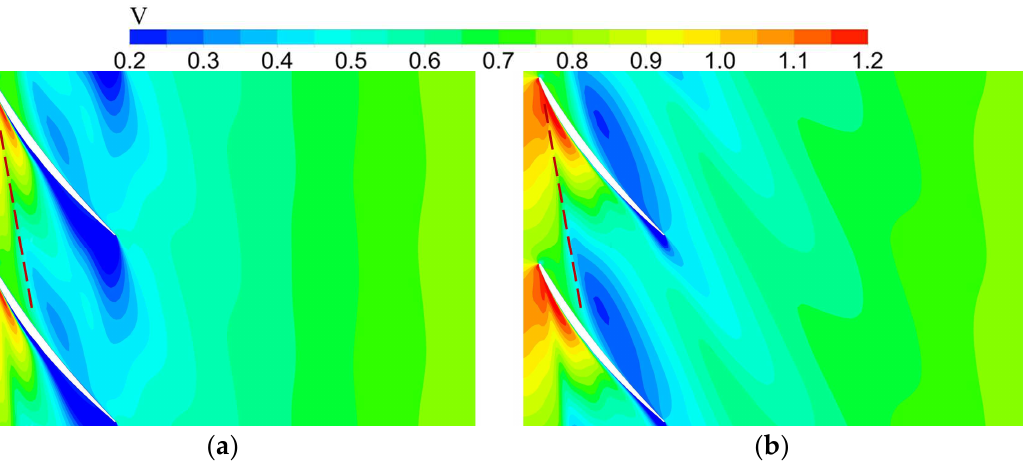
( b ) Figure 19. Distribution of time-averaged relative velocity and the line of wake and TCV interaction at 99% span. ( a ) Re = 1 × 10 5 ; ( b ) Re = 4 × 10 5 .